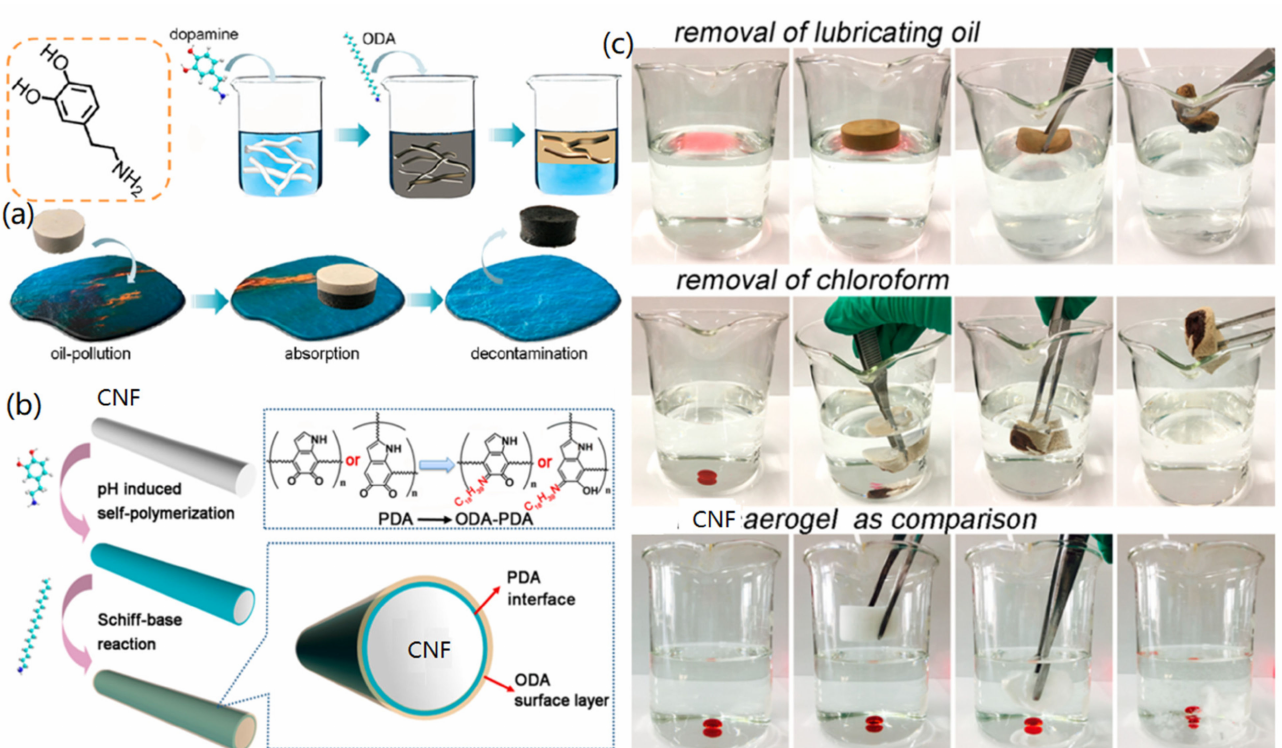
Figure 8. PDA/ODA-modified CNFs for the synthesis of aerogels for oil/water separation: ( a ) Fabrication of superhy- drophobic CNF-based aerogels for the removal of oil, ( b ) surface modification of CNFs with PDA and ODA, and ( c ) separation the oil and chloroform from water. Reproduced with permission from Ref. [103], Copyright 2018, American Chemical